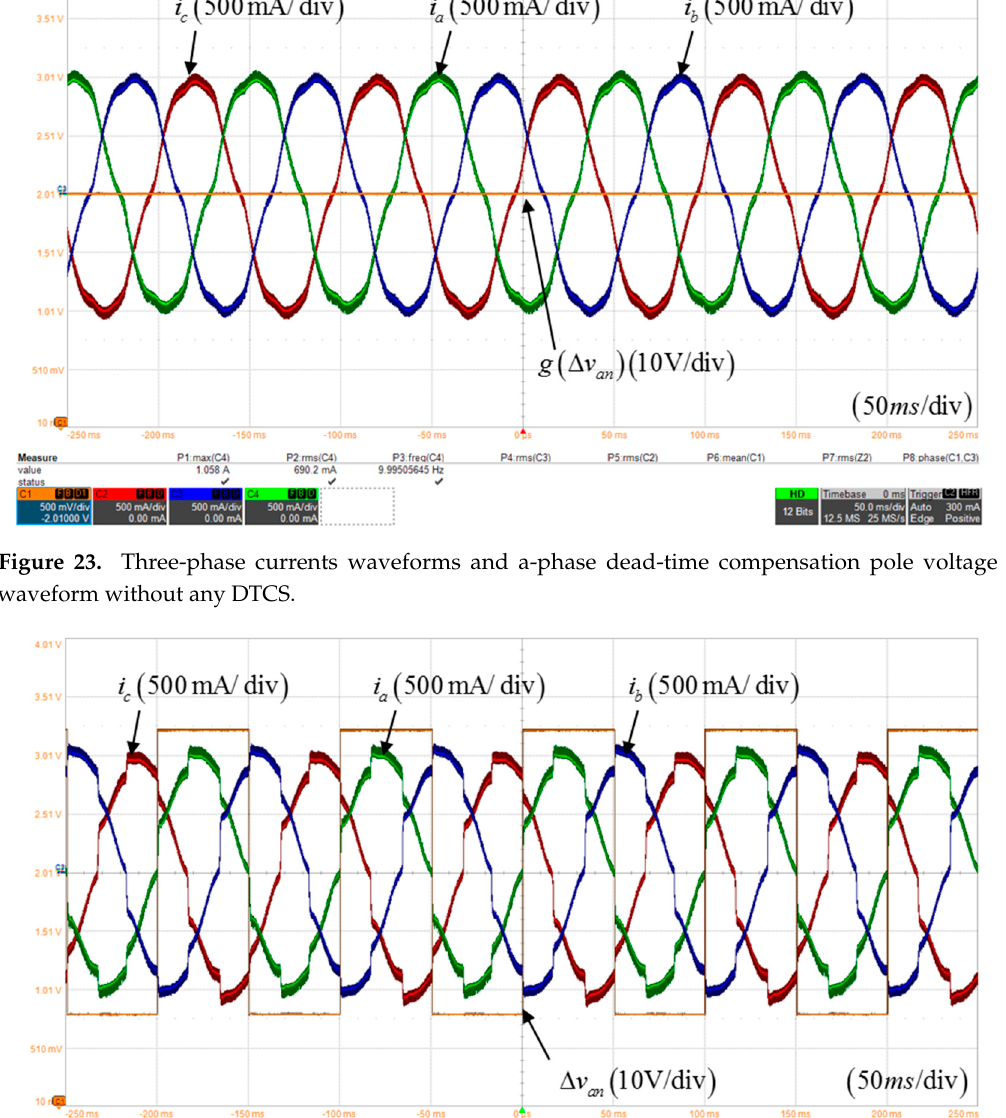
T was applied. T was applied. d d